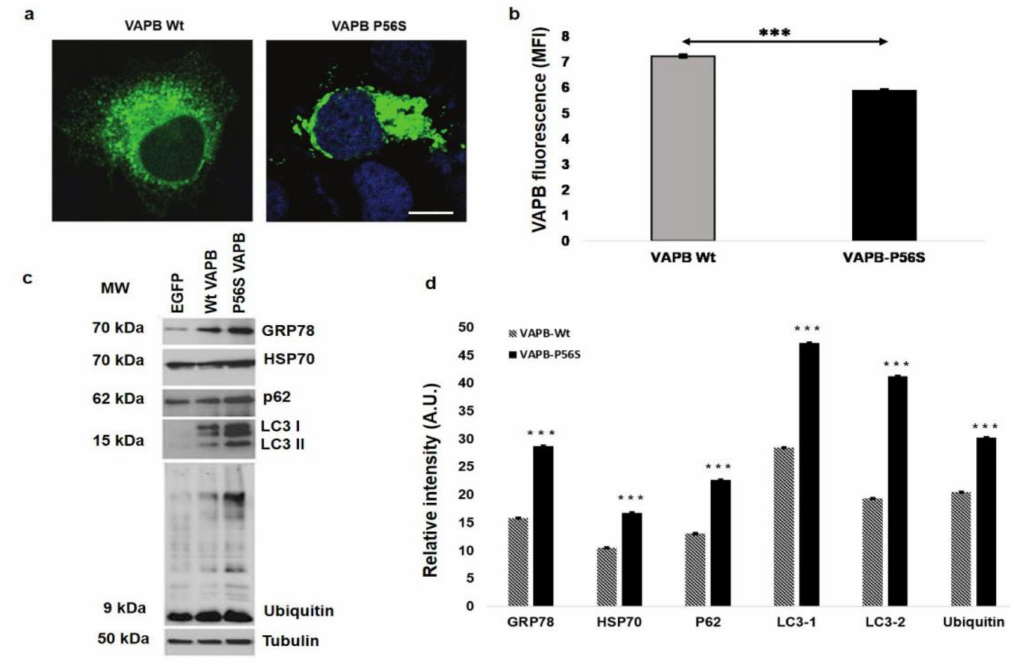
Figure 2. Representative immunofluorescence images performed with an antihuman VAPB polyclonal antibody in Hela cell lines. ( a ) VAPB (green) and nuclei (blue) in HeLa cells transfected with VAPB-Wt (left) and VAPB-P56S (right). Magnification is the same in both pictures (scale bar: 15 µ m). The image shows VAPB aggregates and ER disorganization in VAPB-P56S-transfected HeLa cells caused by VAPB misfolding. ( b ) FCAs performed with an antihuman VAPB monoclonal antibody. The data, expressed as medium intensities of fluorescence (MFIs), show a statistically significant reduction of fluorescence signals in VAPB-P56S-transfected HeLa cells compared to in VAPB-Wt-transfected HeLa cells. ( c ) Representative western blot analysis showing the expression of GRP78, p62, and LC3 proteins and ubiquitin protein in VAPB-Wt- and VAPB-P56S-transfected cells. β -tubulin was used as a loading control. For each analysis, around 15 µ g of protein were loaded. All western blot experiments were performed in triplicate. ( d ) Quantification of band intensities normalized with a β -tubulin value depicted in (c). Densitometry analysis was performed using the software ImageJ. Data are from one representative experiment out of three. *** p <